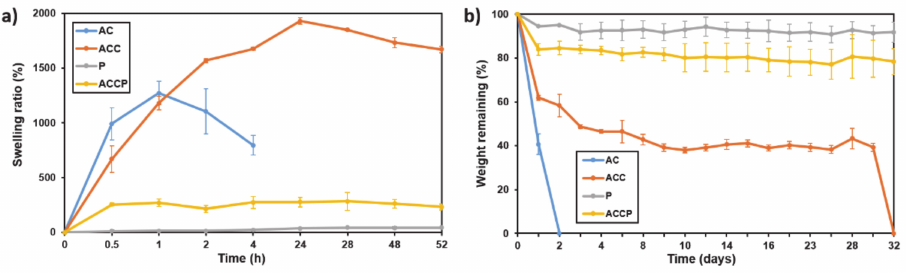
Figure 4. ( a ) Scaffold swelling test. ( b ) Scaffold degradation